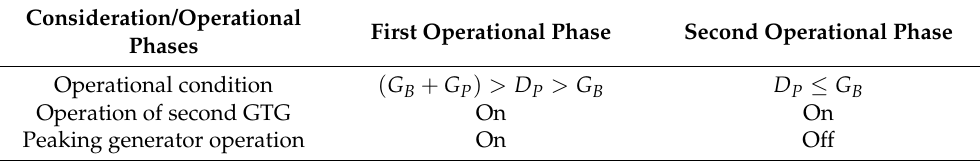
Figure 3. Various operational modes of the capacity addition technique. Table 3. Conditions of the different operational phases of the capacity addition